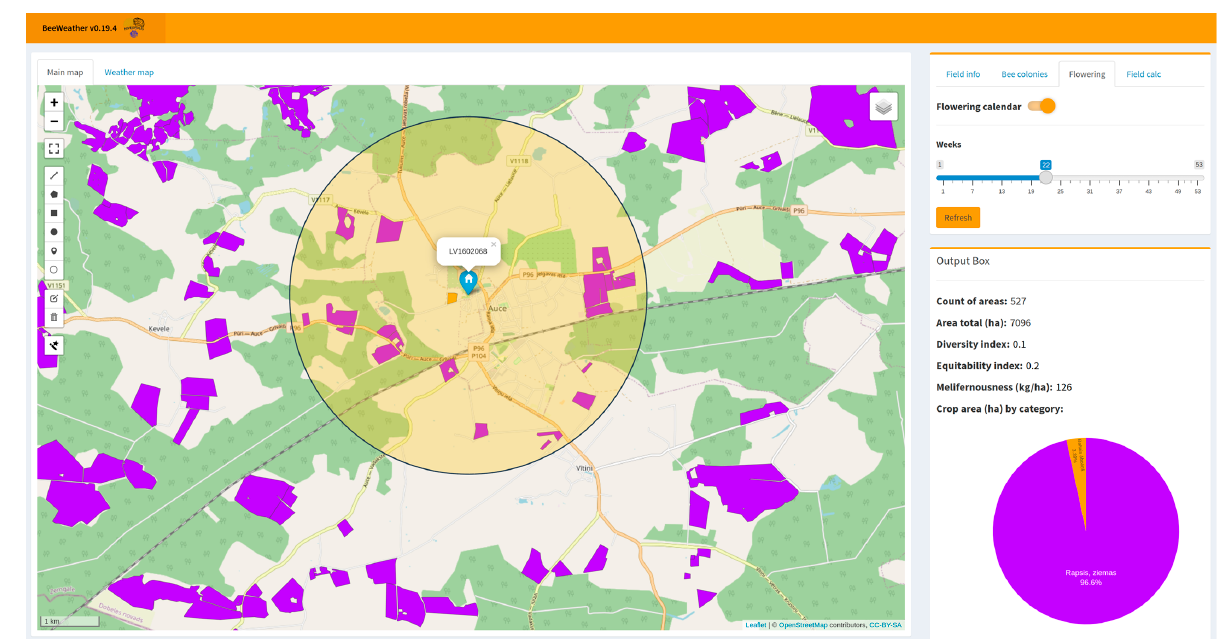
Figure 7. Croplands within the foraging radius of the apiary location.